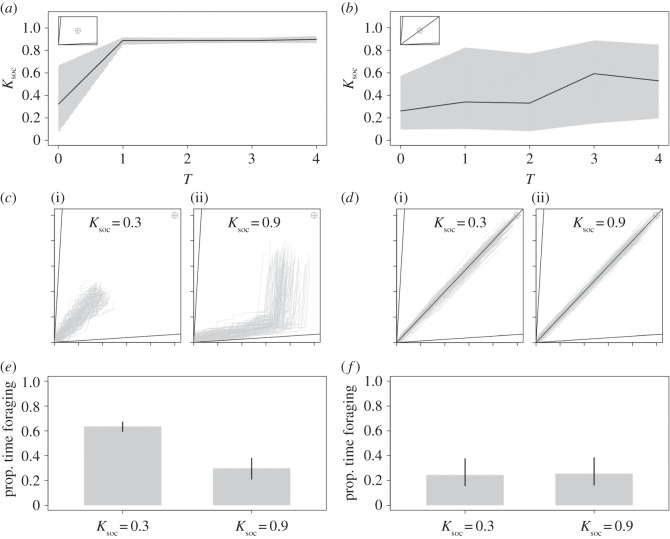
Time-costs to foraging and the evolution of collective foraging. Mean and 0.025–0.975 quantile of Ksoc after 1000 generations at differing levels of T based on 30 model runs in (a) a two-food and (b) a three-food environment for homogeneous groups of individuals with a single IT. Embedded in each panel is a geometric depiction of the nutritional environment showing the modelled food rails (V). Traces of the movement of 100 agents through the nutrient space (grey lines), and their intake targets (grey cross hair) where T = 4 and Ksoc = 0.3 (i) and Ksoc = 0.9 (ii) in (c) a two-food environment and (d) a three-food environment. The mean (±0.025–0.975 quantile) proportion of that model run spent foraging (i.e. moving between foods), by those individuals in (e) a two-food environment and (f) a three-food environment. σIT = 0 in all instances (see table 1 for all parameters and variables).